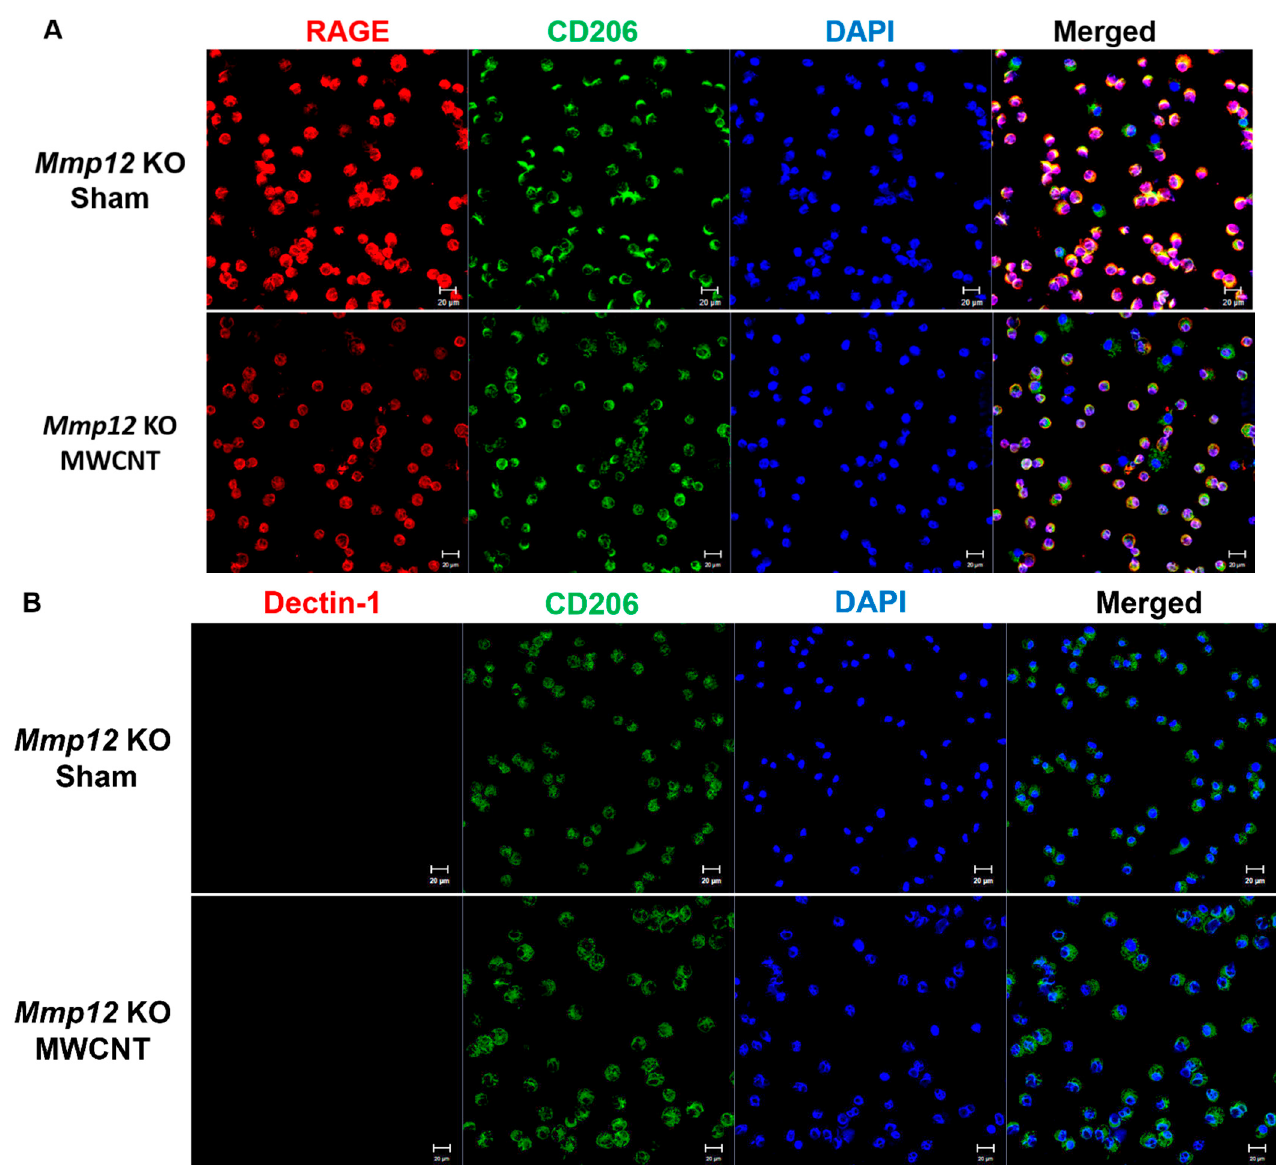
Figure 2. RAGE, a marker associated with the M2c macrophage phenotype, is prevalent in 10-day BAL cells from Mmp12 KO mice. ( A ) Anti-RAGE staining of 10-day BAL cells from Mmp12 KO MWCNT- and sham-instilled mice detected RAGE expression (co-stained with conjugated CD206). ( B ) Anti-Dectin-1 staining of Mmp12 KO MWCNT and sham BAL cells showed no expression of the M2a macrophage marker, Dectin-1, at 10 days (co-stained with conjugated CD206). Representative images of n ≥ 3 animals.